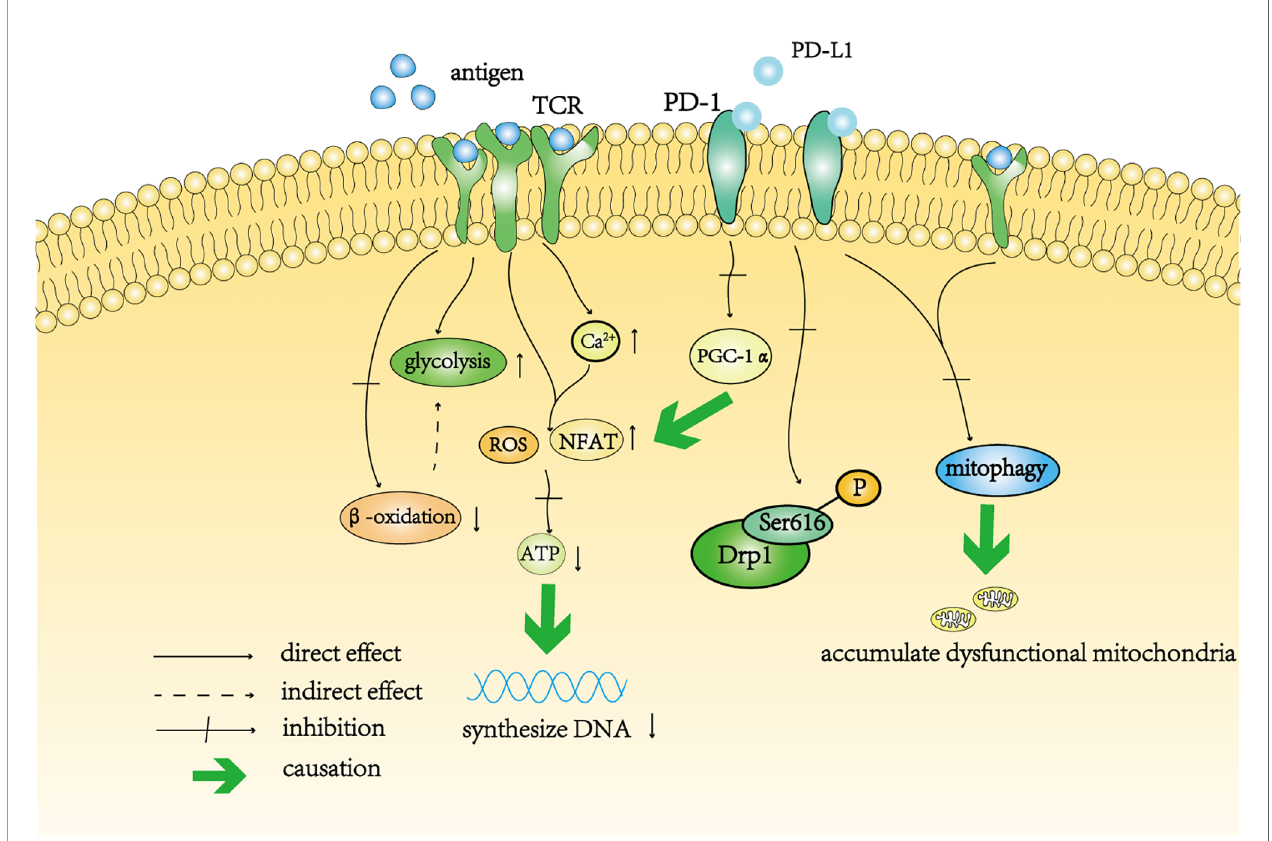
FIGURE 2 | A schematic diagram of T cell depletion caused by continuous antigen stimulation and PD-1. Continuous antigen stimulation increased the level of glycolysis in T cells and inhibited beta-oxidation in these cells. The decrease in oxidative phosphorylation indirectly increases the level of glycolysis. In addition, continuous antigen stimulation not only directly increases the levels of intracellular ROS and NFAT, but also increases the level of intracellular calcium, resulting in the accumulation of intracellular ROS indirectly. High levels of ROS affect the synthesis of ATP, thereby affecting the synthesis of DNA in T cells. Activation of the PD-1 signal pathway inhibits the transcription of PGC-1 a , resulting in an increase in the level of ROS. The PD-1 signal pathway also inhibits the phosphorylation of Drp11 at Ser616. Continuous antigen stimulation cooperates with the PD-1 signaling pathway to prevent mitochondrial autophagy and self-renewal, resulting in the accumulation of dysfunctional mitochondria in T